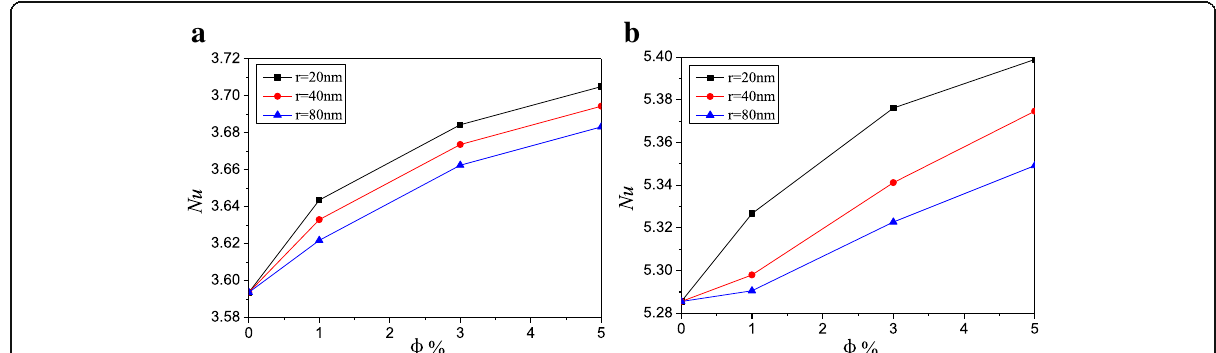
Fig. 6 Average Nusselt numbers with different nanoparticle radiuses, A =2:1. Average Nusselt numbers of Ag-Ga nanofluid with different nanoparticle radiuses along with the left hot wall, A =2:1. a Ra =10 3 . b Ra =10